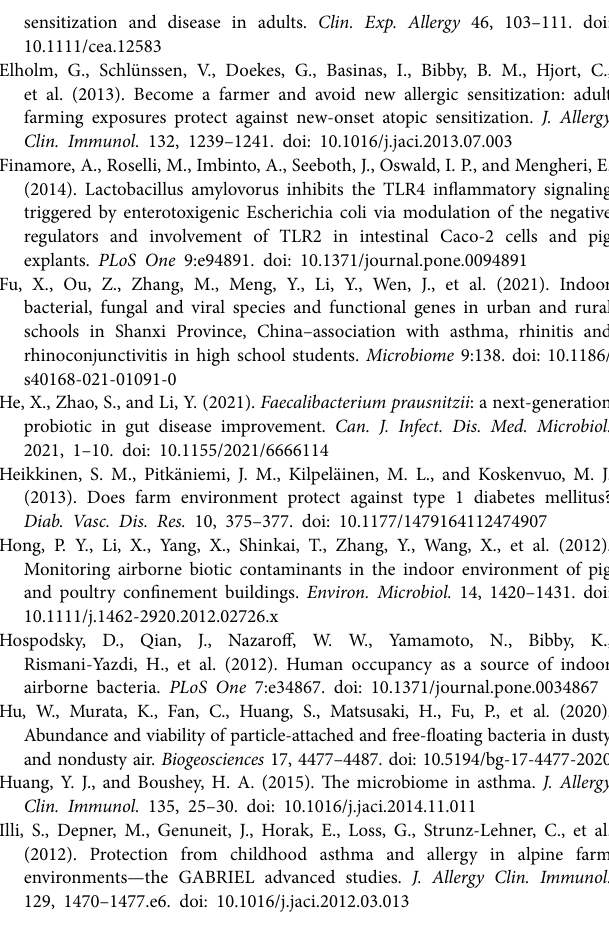
Supplementary Figure 1 | Dot-plot of quantitative PCR measurements of cow farmers’ homes and cow stables based on season. The 10 dots in the dot-plot represents the results of 10 measurements. The horizontal lines are whiskers of 1.5 IQR of the upper quartile and lower quartile The significance of the differences depicted in this figure is demonstrated in the inset box, which contains Wilcoxon rank sum test results. P values less than 0.05 is significant.